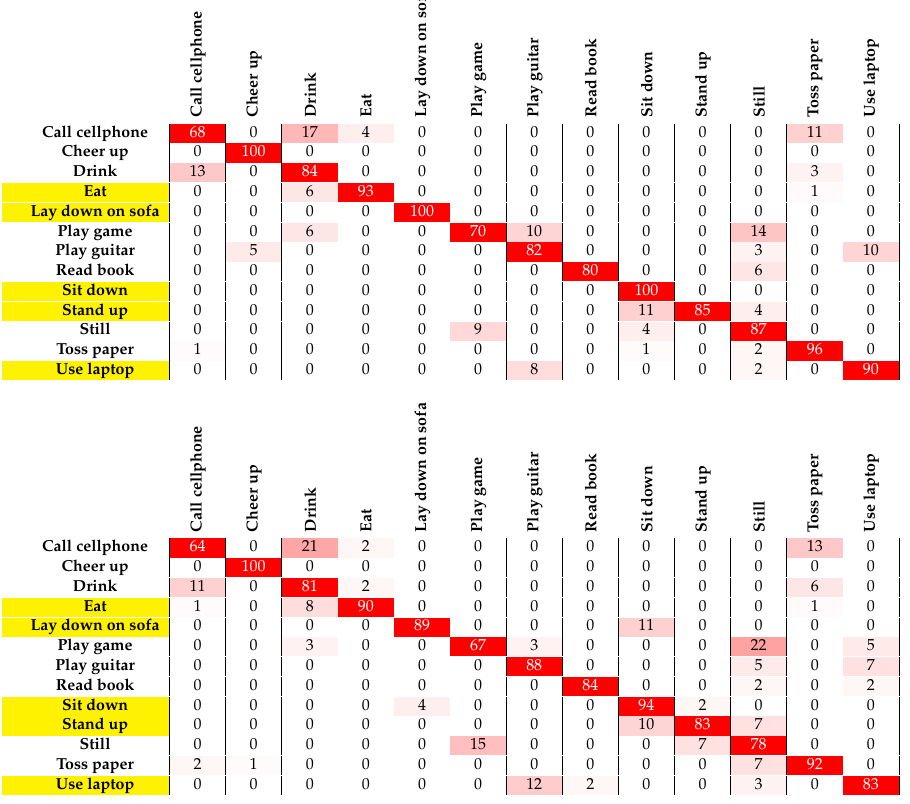
Figure 7. Confusion matrices of the proposed method for the actions in the sitting pose (top) and the actions in the standing pose (bottom) in terms of MSR daily activity 3D data-set [36]. Actions that are used in the simulation are highlighted.